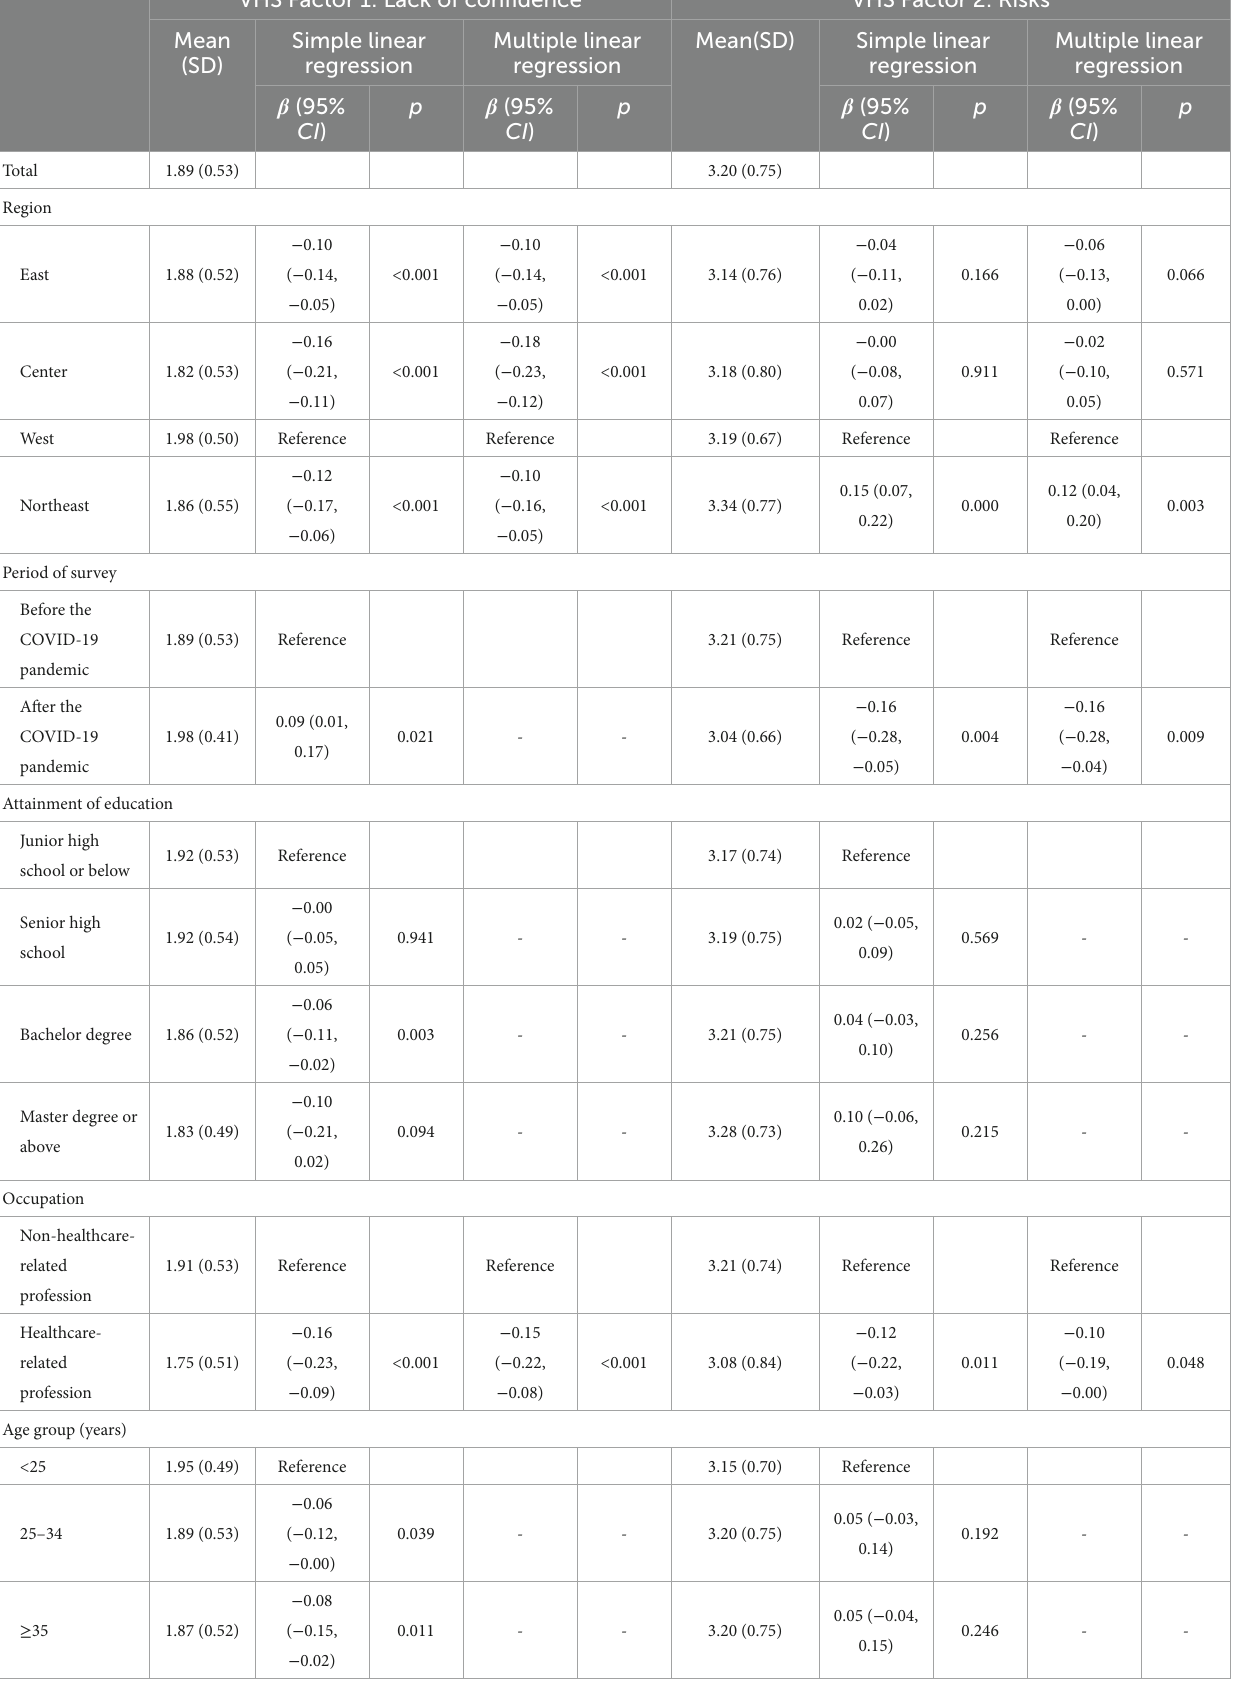
TABLE 3 Demographic characteristics and their relation to two components of vaccine hesitancy. VHS Factor 1: Lack of confidence VHS Factor 2: Risks Mean Simple linear Multiple linear Mean(SD) Simple linear Multiple linear (SD) regression regression regression